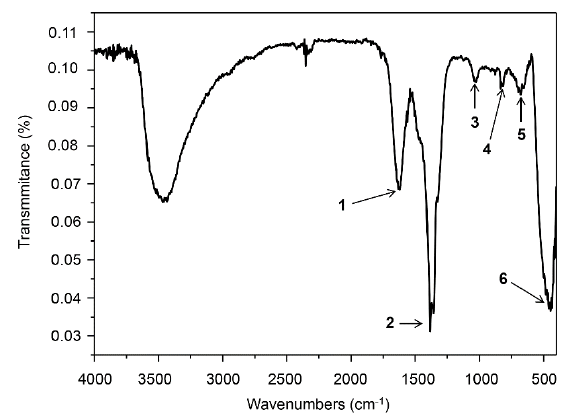
Figure 3. FT ‐ IR spectra for biologically synthesized ZnO NCs in the υ = 400–4000 cm − 1 range; υ (cm − 1 ):